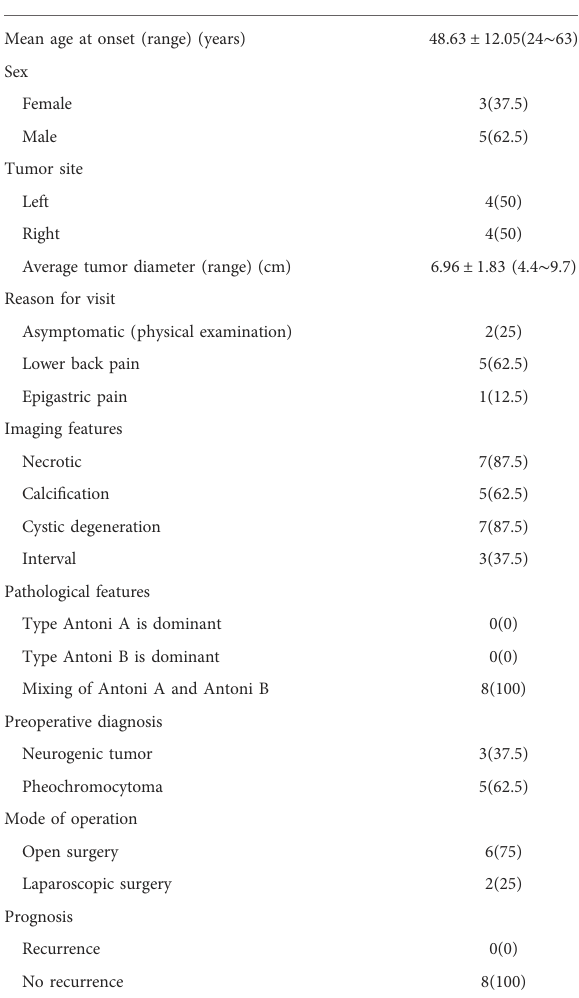
TABLE 1 Demographic and clinical characteristics of eight patients with adrenal schwannoma. Patient